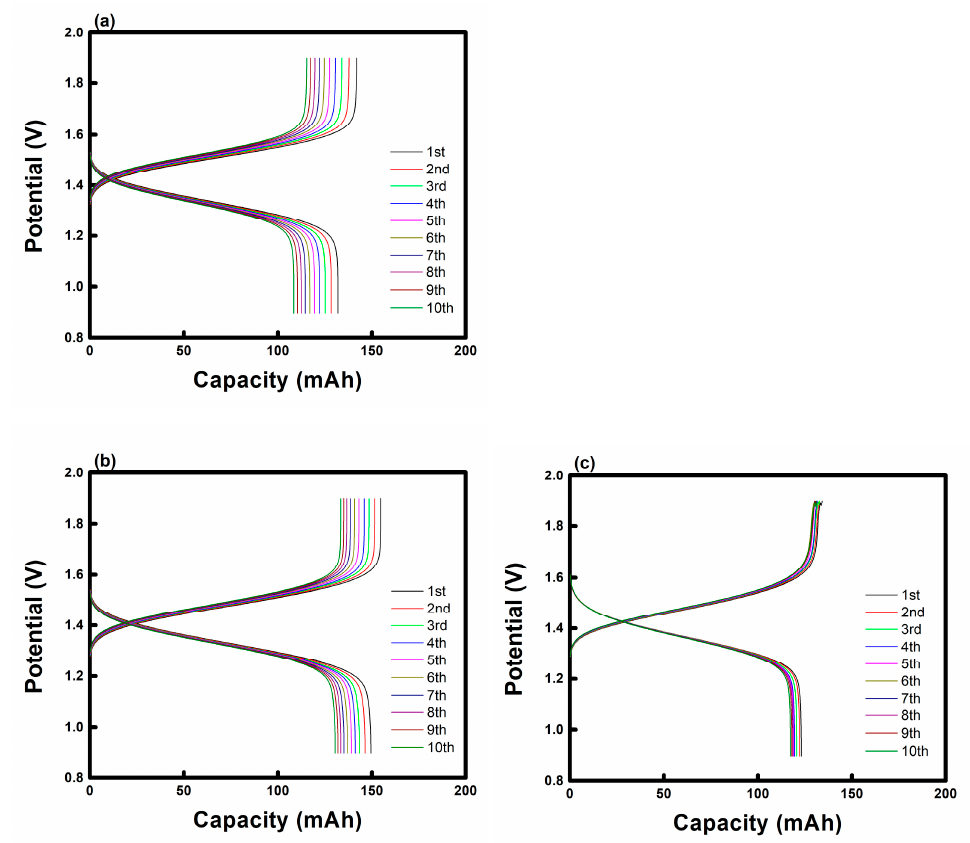
Figure 7. VRFB charge–discharge performances of ( a ) AMX, ( b ) Hydrophobic-PTFE based PFAEM, and ( c ) Hydrophilic-PTFE based PFAEM. Table 4. Various characteristics of commercial and prepared membranes.